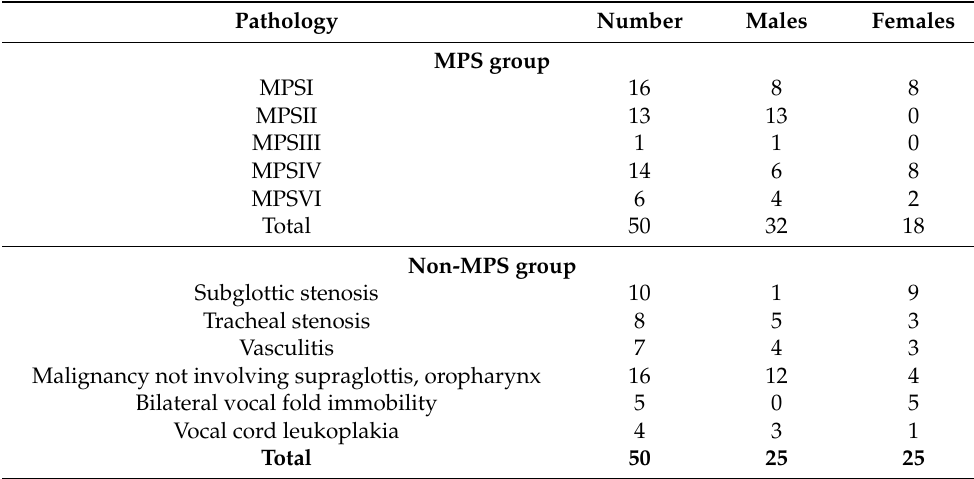
Table 3. Clinical diagnosis of different patients in the MPS and non-MPS groups. MPS—